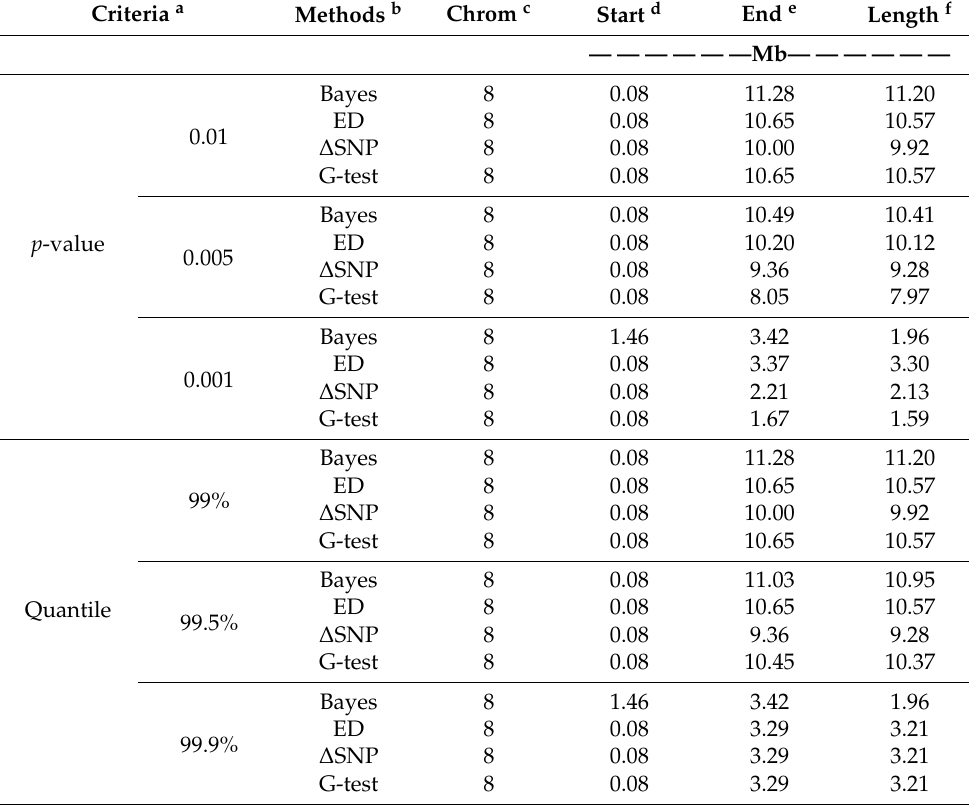
Table 1. The candidate region for maize small-kernel mutant identified by PNGseqR. Criteria a Methods b Chrom